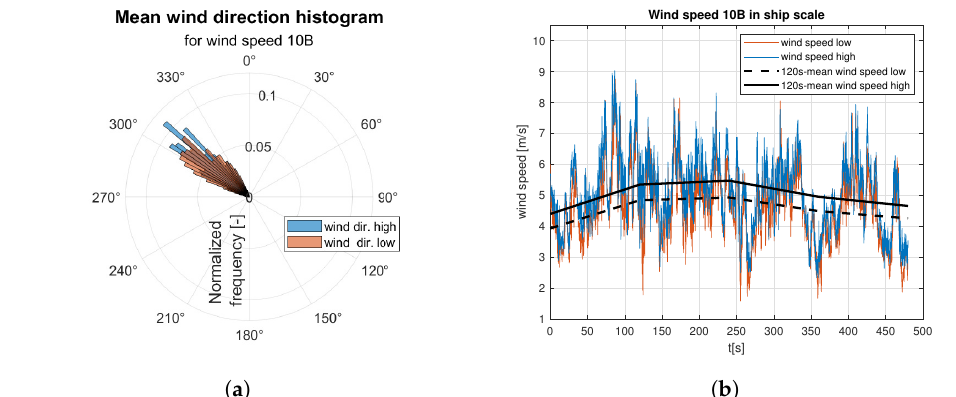
Figure 14. Raw measurements for strong wind—10BFT in ship scale: ( a ) wind rose; ( b ) time series.